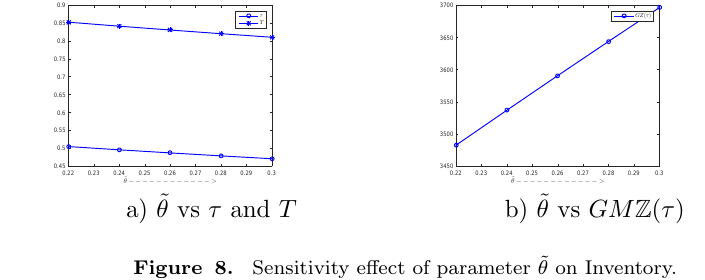
Figure 8. Sensitivity effect of parameter ˜ θ on Inventory.